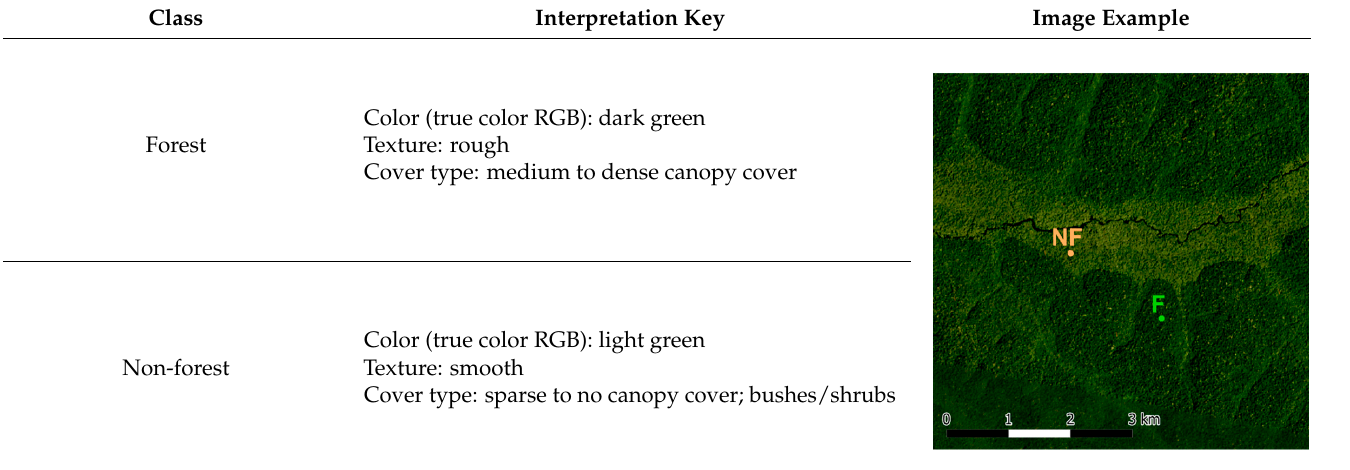
Table 2. Interpretation keys for labeling forest/non-forest training and validation points. F = Forest; NF = Non-Forest. Class